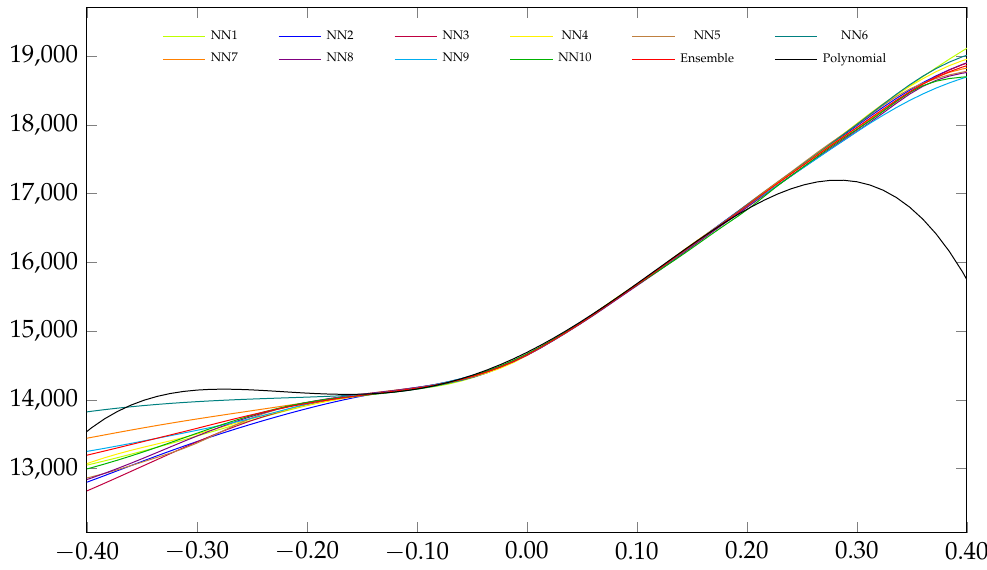
Figure A3. One-dimensional curves of the 10 best performing neural networks, their ensemble and the polynomial with respect to X 1 .